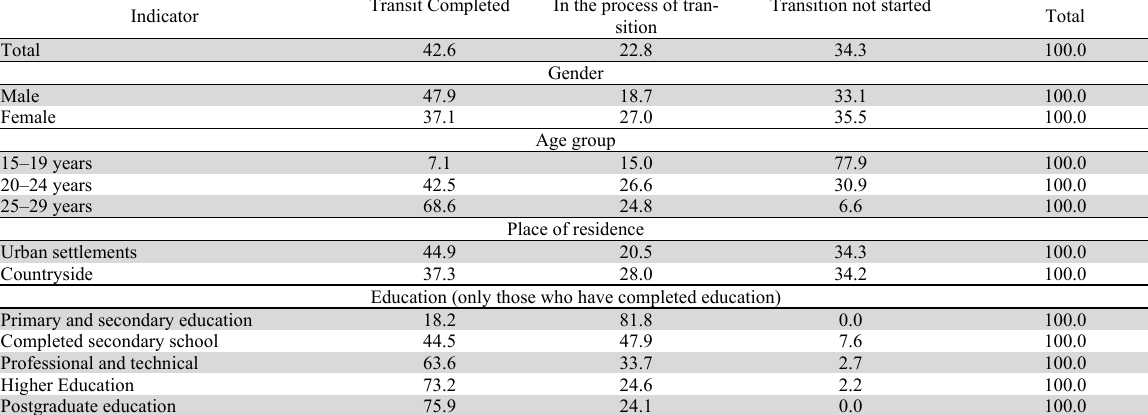
Transition stage based on gender, age, place of residence and education level (in percentage Transition not started Transit Completed In the process of tran- Indicator sition